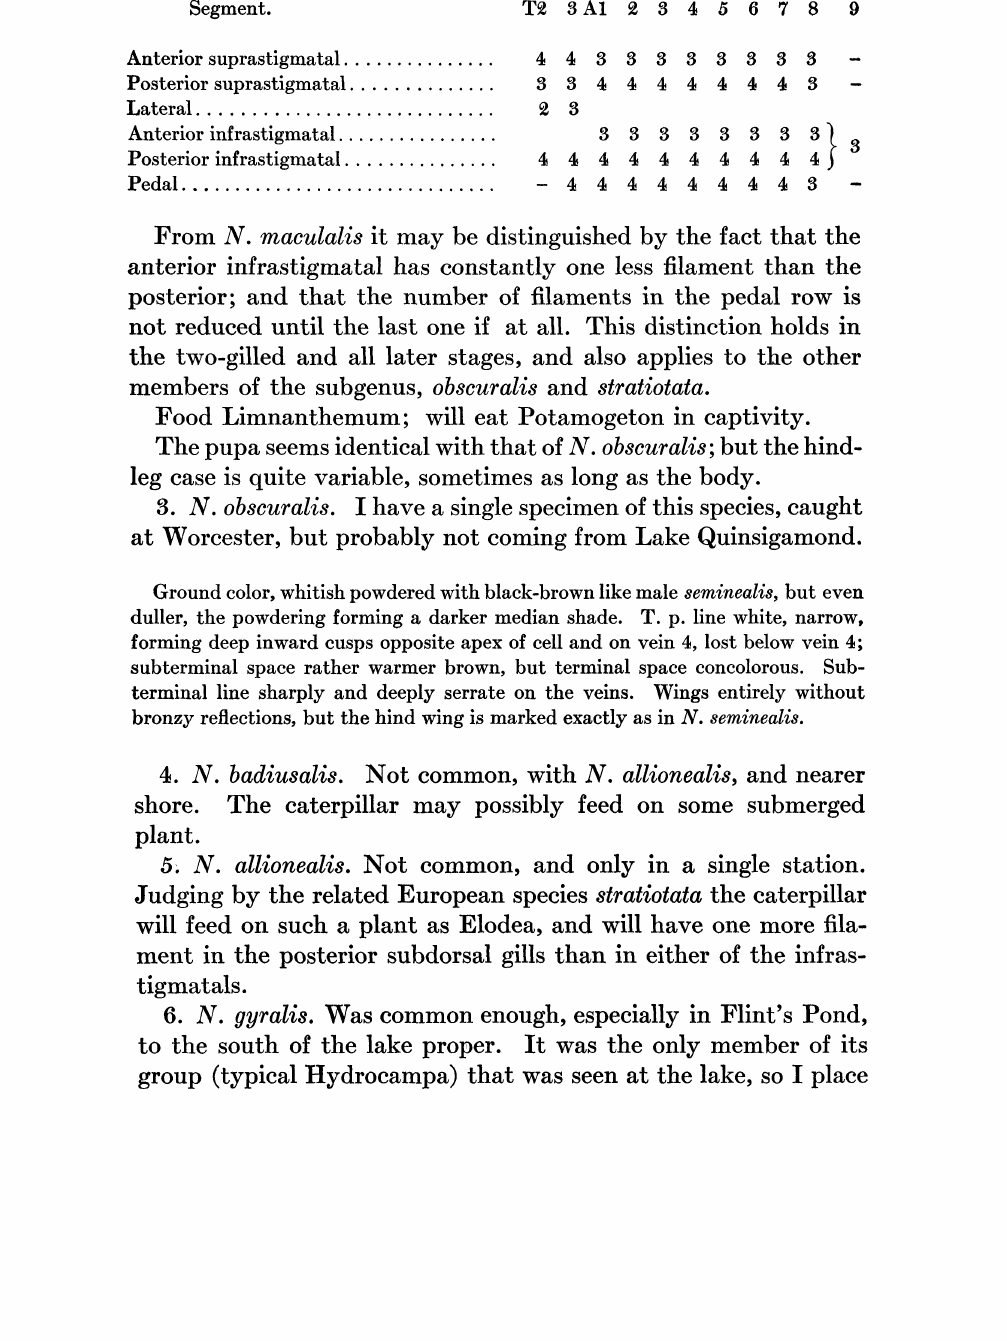
Anterior suprastigmatal Posterior suprastigmatal Lateral Anterior infrastigmatal Posterior infrastigmatal